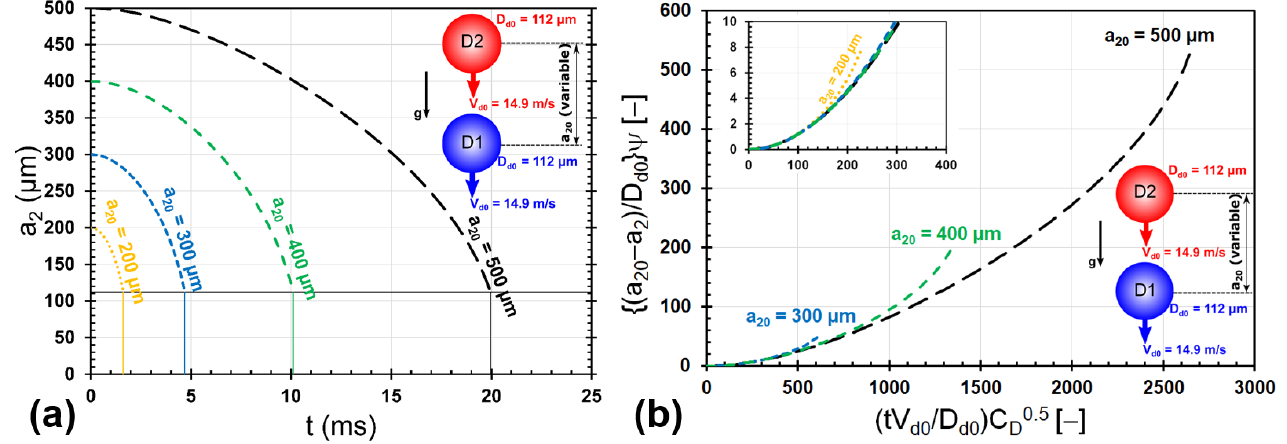
Figure 12. Effect of a 20 on a 2 ( t ) : ( a ) Time evolution of the center-to-center separation of iso- propanol droplets in the double-droplet system, as predicted by Equation (13), for four typical cases of a 20 : 200, 300, 400, and 500 µ m. Other parameters are kept the same as in Figure 4: D d 0 = 112 µ m; V d 0 = 14.9 m/s; C D is calculated using Equation (10). ( b ) Non-dimensionalized version of the plot shown in ( a ) using the non-dimensionalization discussed in Appendix C. In the vertical axis, the (cid:20)(cid:16) (cid:17)(cid:21) (cid:17) 2 (cid:16) (cid:17) 2 (cid:30)(cid:16) a 20 2 a 20 2 a 20 + 1 − 1 factor ψ = . The inset shows a magnified version to show the D d 0 D d 0 3 3 D d 0 trend for a 20 = 200 µ m more